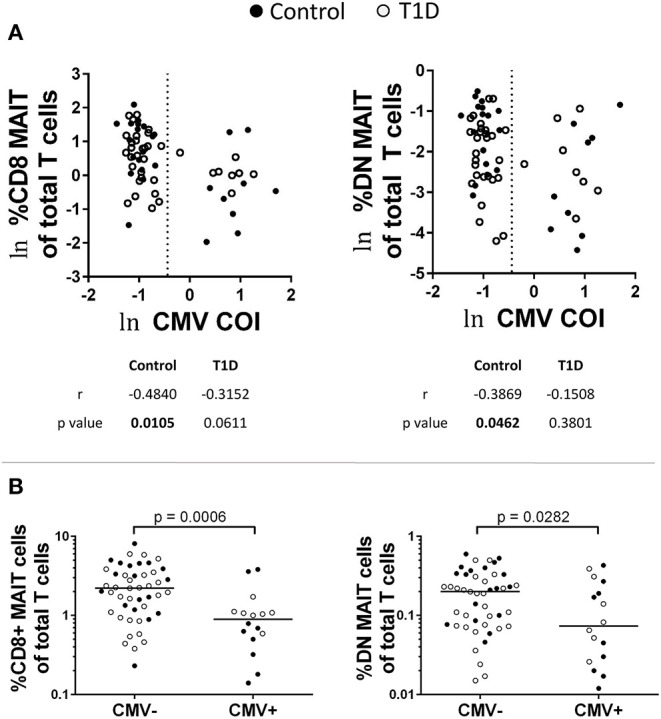
Influence of previous cytomegalovirus (CMV) infection on CD8 and DN MAIT cell frequencies. (A) Correlations between CD8 and DN MAIT cell frequencies and CMV cut off index (COI). (B) Frequencies of CD8 and DN MAIT cells among pooled T1D and control subjects that were stratified according to CMV seropositivity. For (A), ln denotes that values were transformed using natural logarithm and dotted line represents cutoff point for determining CMV seropositivity.